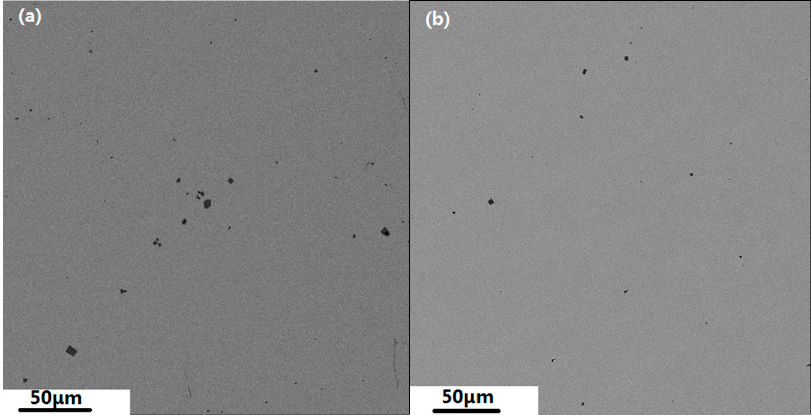
Figure 6. SEM observation for TiN inclusions of industrial samples. ( a ) mold floater and ( b ) 321 steel.